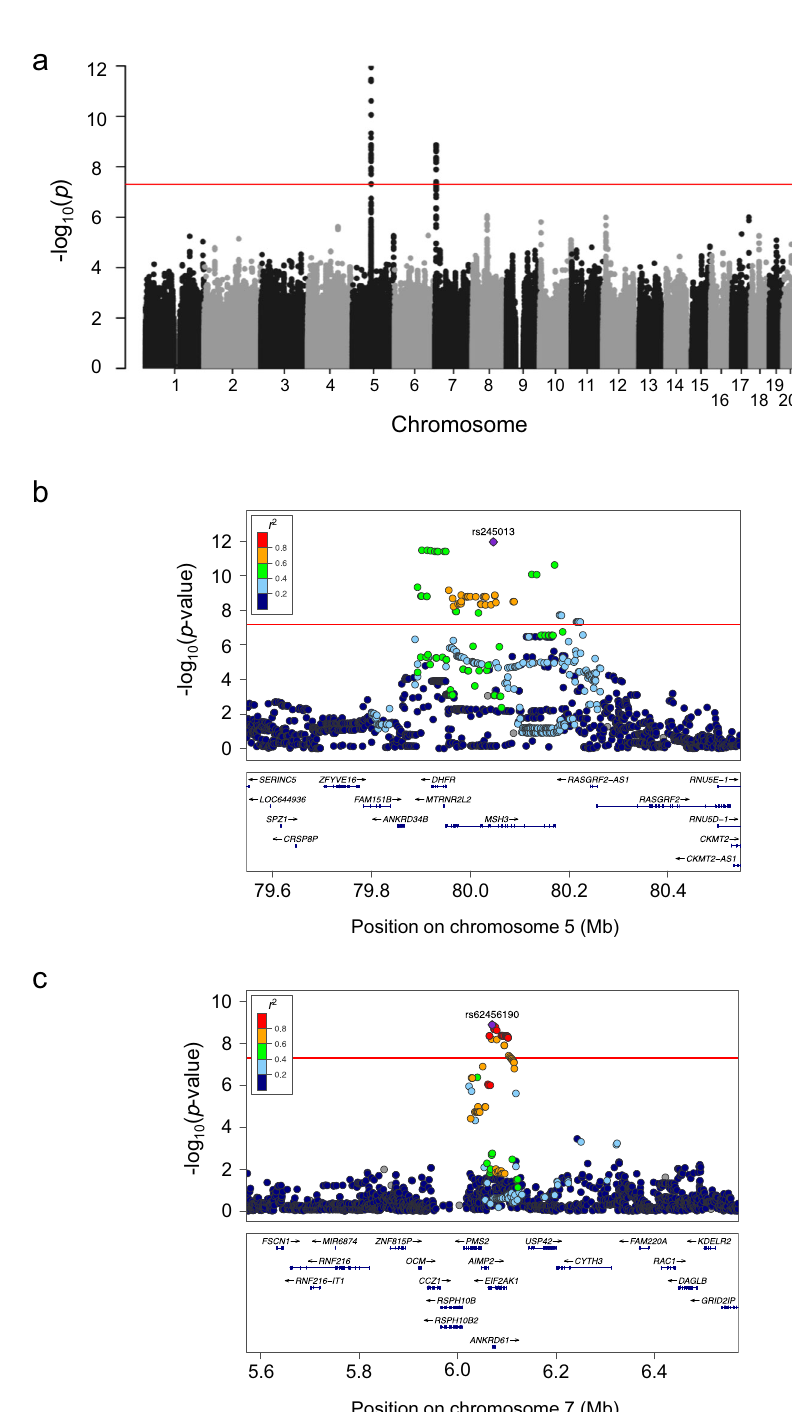
Fig. 1 Genome-wide association study (GWAS) on age at onset (AAO) in X-linked dystonia-parkinsonism (XDP) patients. a Manhattan plot of the XDP AAO GWAS. We estimated a series of linear regression models assuming SNPs with a p -value below 5 × 10 − 8 to be signi fi cantly associated with AAO adjusted for repeat number. Using this approach, we identi fi ed 93 candidate SNPs to cover a potential genetic modi fi er in fl uencing AAO. b , c Locus zoom plot of the GWAS data. The structure of linkage disequilibrium and – log10 ( p -value) of the identi fi ed loci on chromosomes 5 and 7, respectively. Genomic coordinates are given according to GRCh37. Red lines: p = 5 × 10 − 8 ; Mb: megabase; each dot: − log10 ( p -value) of a SNP; r 2 : the Pearson coef fi cient of correlation between any SNP in the graph and the SNP with the lowest p -value in that region. Source data are provided as a Source data fi exon 1 of MSH3 in 95 additional XDP patients whose mean AAO Table 1) with a validation rate of over 99%. and hexanucleotide repeat number did not differ from the GWAS Sequence analysis of MSH3 exon 1 revealed ten single- cohort (Supplementary Table 3). After adjustment for SVA nucleotide and in-frame sequence length polymorphisms in close hexanucleotide repeat number, we calculated the impact on AAO proximity of p.Ile79Val (Supplementary Table 3). We sequenced of eight variants (including p.Ile79Val) in MSH3 exon 1 with a